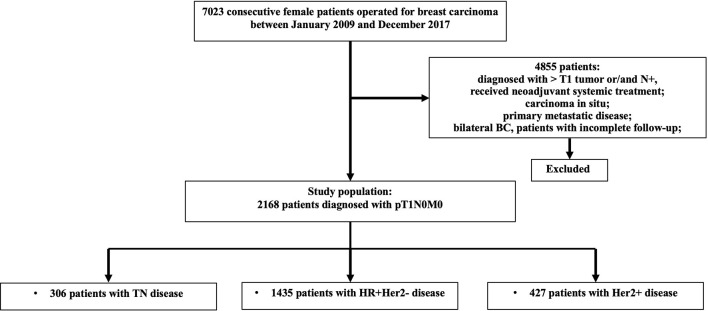
Identification of the study population.